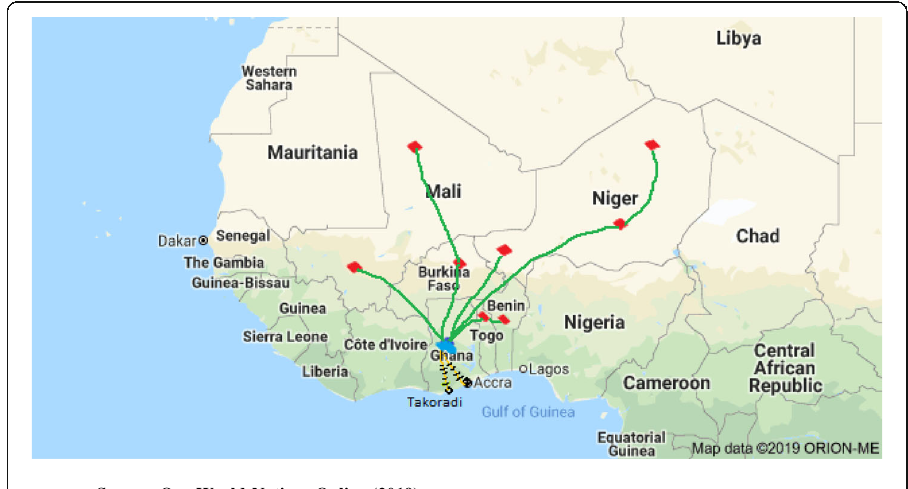
Fig. 3 The Geographical Mapping of the Boankra Inland